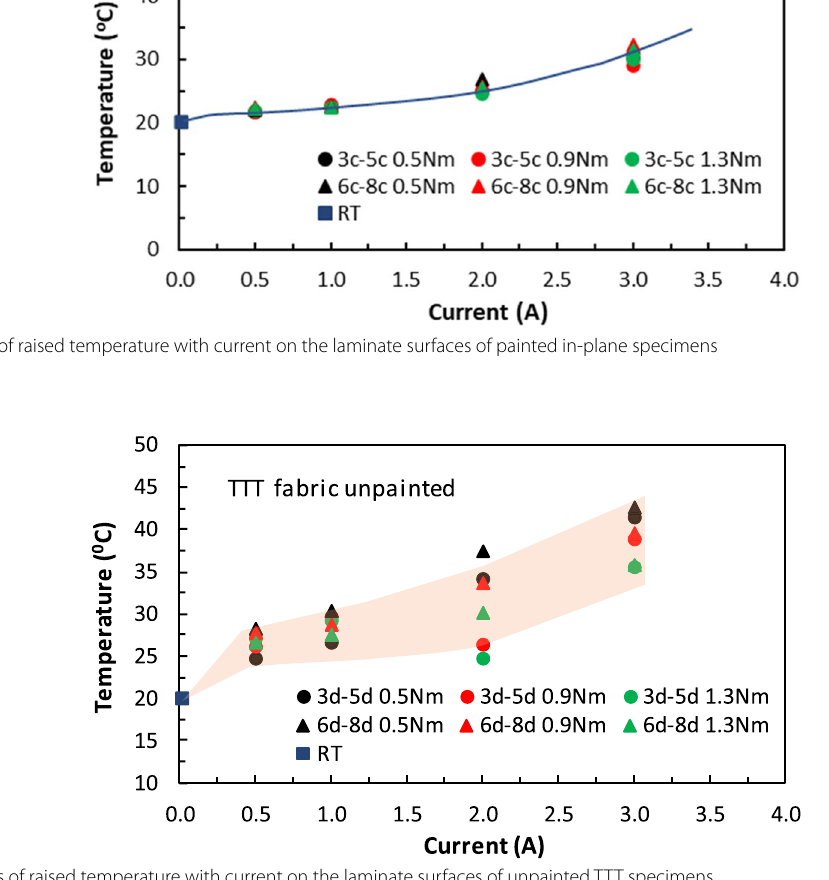
Fig. 10 Variations of raised temperature with current on the laminate surfaces of unpainted TTT